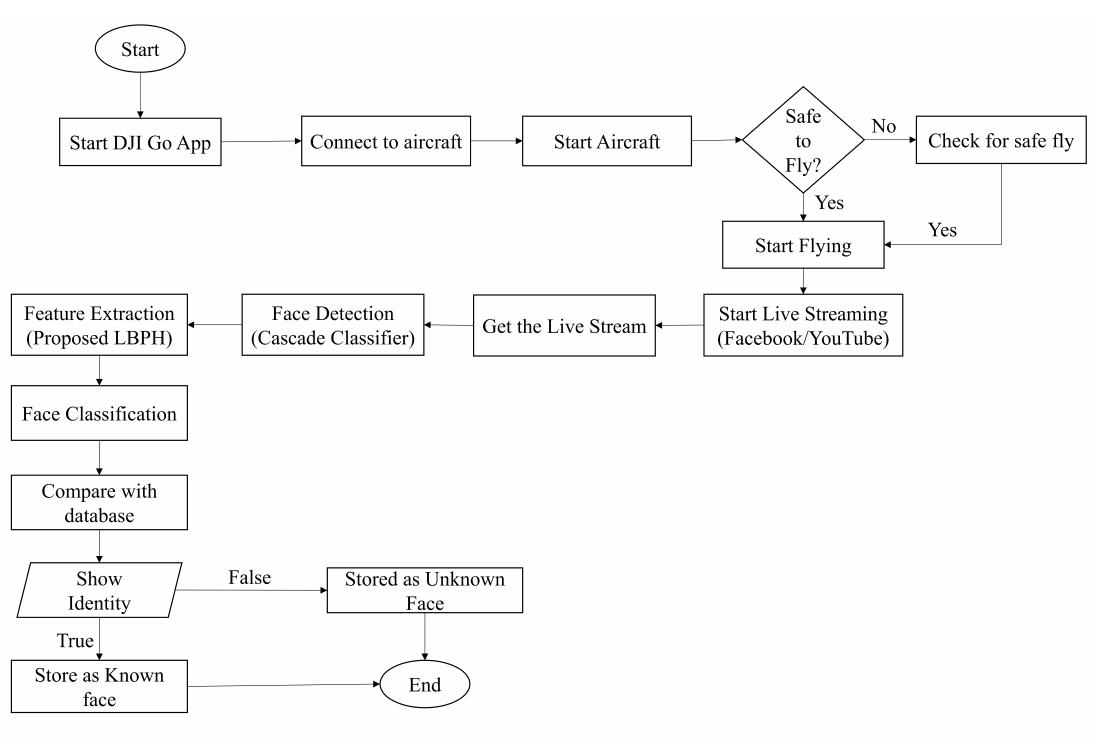
Figure 7. Flow chart of Real time FR using DJI phantom